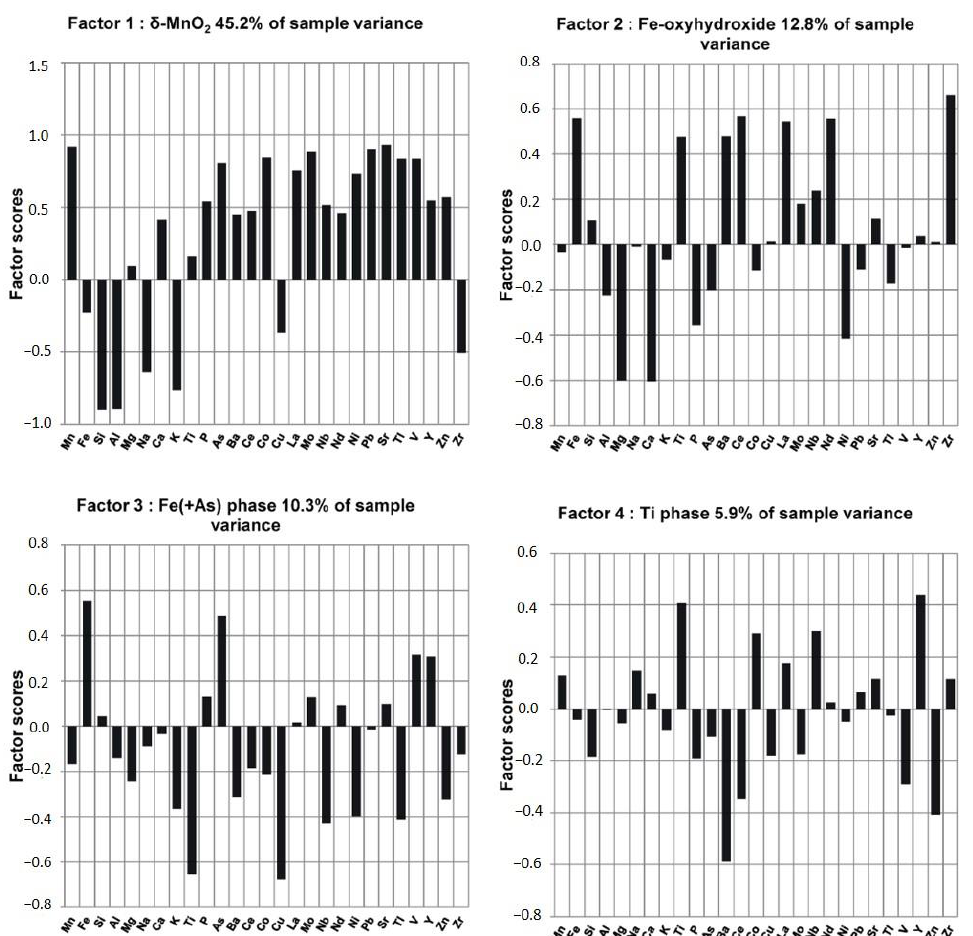
Figure 9. Histograms of factor scores for the four factors (computed for the hydrogenetic bulk and macro-layers samples, n = 89).